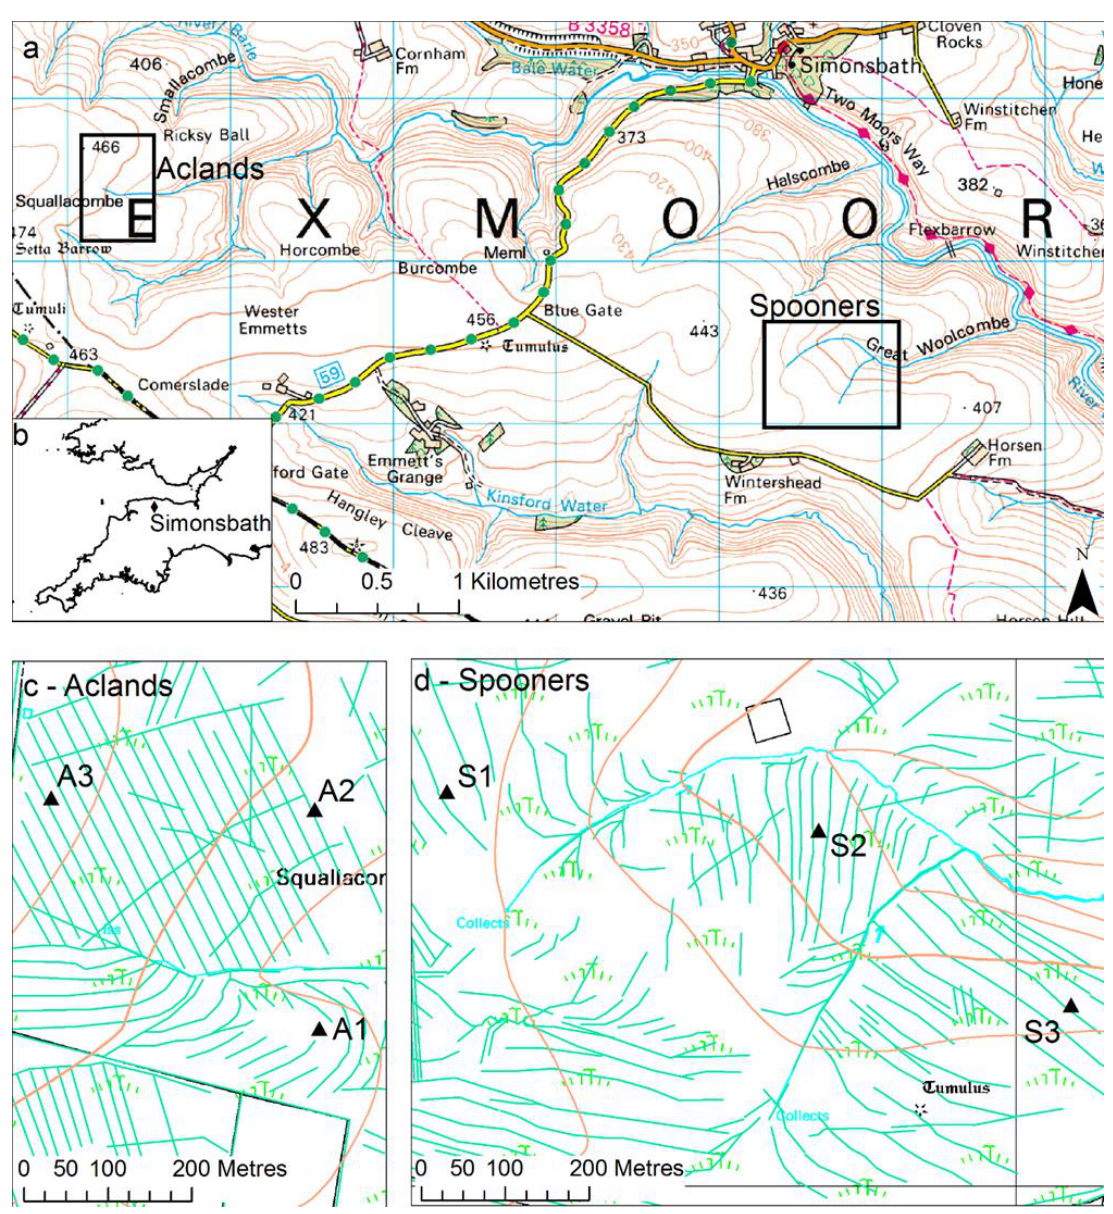
Figure 1. Top: the locations of Aclands and Spooners catchments within Exmoor (a), and of Exmoor within the southwest of England (b). Bottom: locations of study sites within Aclands (c) and Spooners (d) study catchments. Drainage ditches and natural streams are shown in light blue. Base maps: Ordnance Survey (2008,